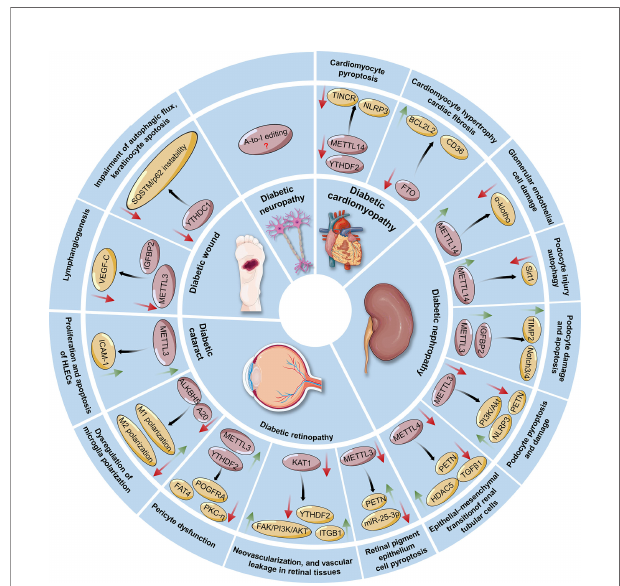
FIGURE 4 | Regulatory roles and possible mechanisms of RNA modi fi cations in the pathogenesis of diabetes-associated complications, including diabetic cardiomyopathy, nephropathy, retinopathy, cataracts, wounds, and neuropathy. The green arrow indicates an increase in the change, whereas the red arrow indicates a decrease in the change. METTL3/14/16 , Methyltransferase-like 3, 14, 16; FTO , Fat mass and obesity-associated protein; ALKBH5 , ALKB homolog 5; YTHDF2 , YT521-B homology (YTH) protein families including YTH domain family 2; YTHDC1 , YTH domain containing 1; TINCR: Terminal differentiation-induced noncoding RNA; NLRP3 , Nucleotide-binding domain (NBD) and leucine-rich repeat (LRR) pyrin-domain containing protein 3; TIMP2 , Tissue inhibitor of metalloproteinases 2; IGF2BPs , Insulin-like growth factor 2 mRNA-binding proteins; HDAC5 , Histone deacetylase 5; ITGB1 , Integrin b 1; KAT1 , Lysine acetyltransferase 1; ICAM-1 , Intercellular adhesion molecule-1; SQSTM1 , Sequestosome 1; VEGF-C , Vascular endothelial growth factor C. HLECs , Human lens epithelial cells; A20 , Also known as tumor necrosis factor-a induced protein 3 (TNFAIP3); ALKBH5 , ALKB homolog